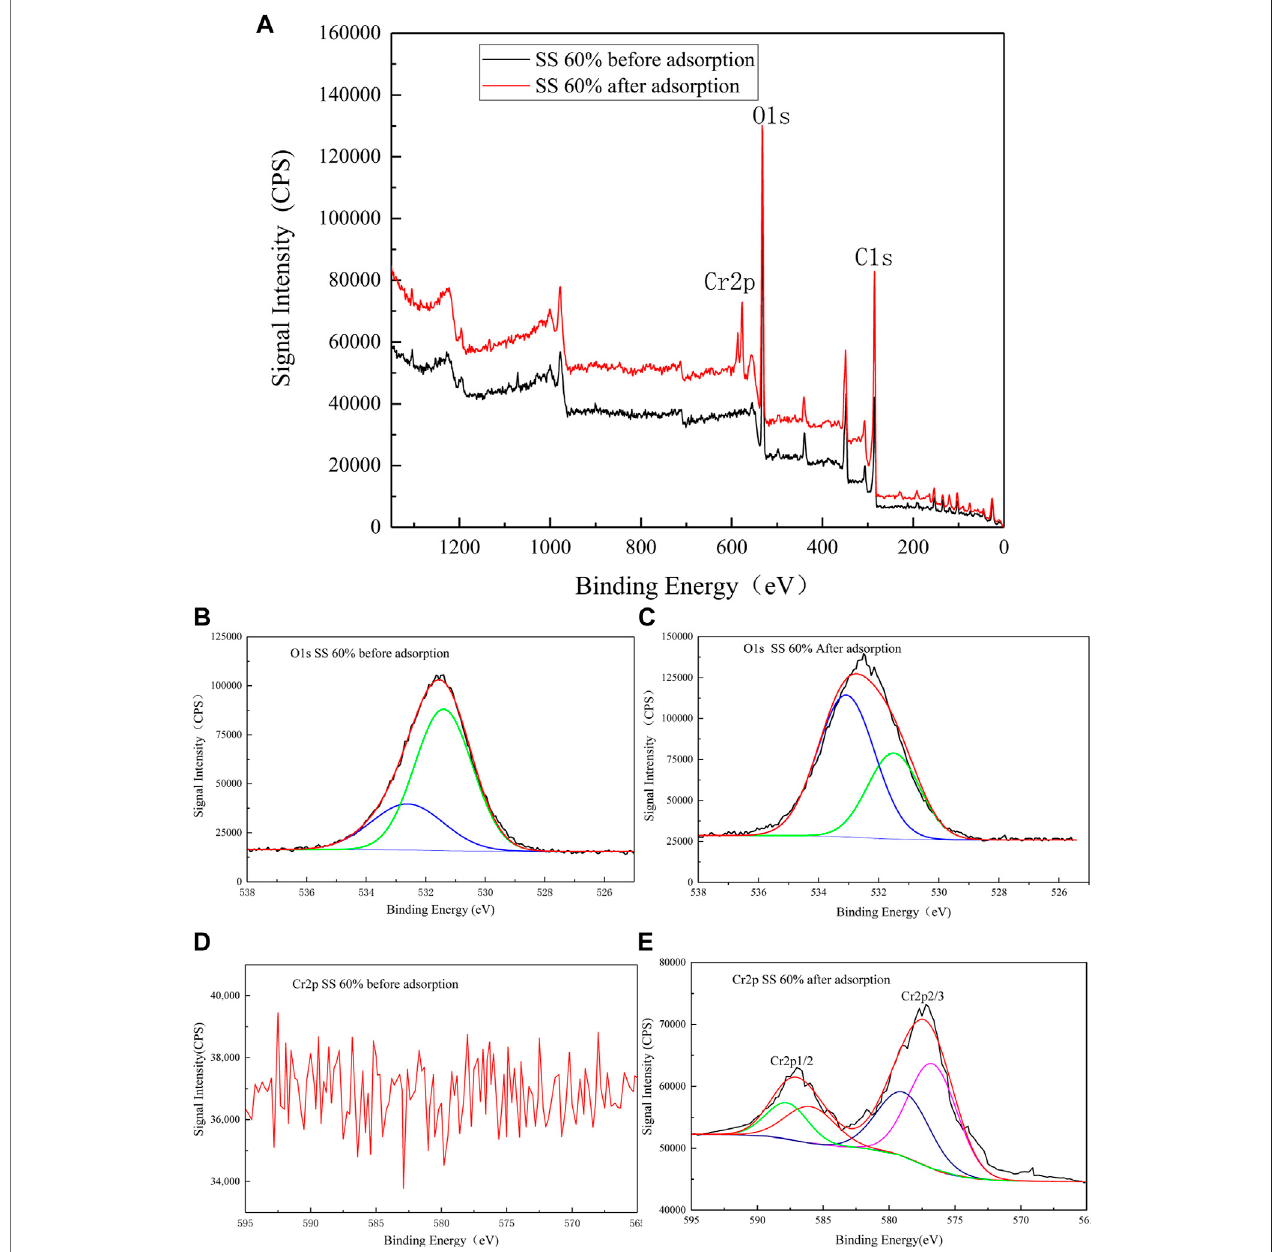
FIGURE7| XPSspectra (A) SS60%beforeandafteradsorptionofCr(VI). (B) O1sSS60%beforeadsorption. (C) O1sSS60%afteradsorption. (D) Cr2pSS60% before adsorption. (E) Cr2p SS 60% after adsorption.